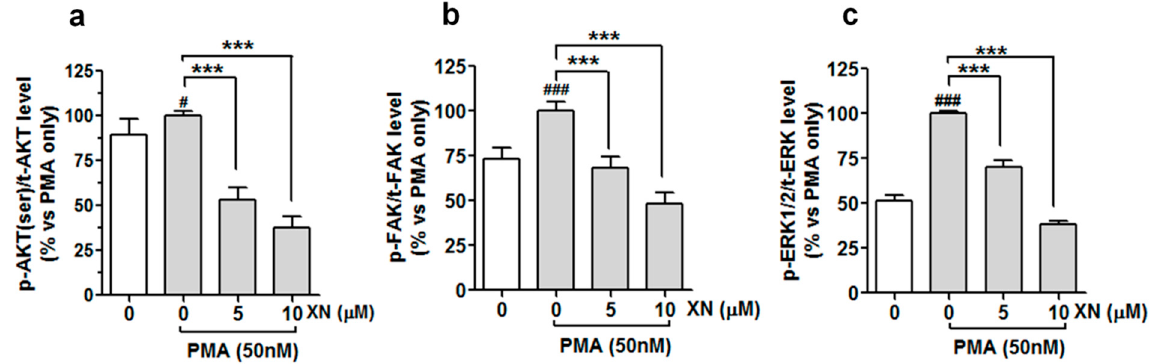
Figure 6. XN interferes with PMA-dependent activation of AKT, FAK, and ERK1/2, kinases in A549 cells. The cells were pre-treated with XN for 4 h and then co-treated with PMA for 24 h; the amounts of phosphorylated ERK1/2, FAK, and AKT were determined with the ELISA assay. Quantitative analysis of ( a ) p-AKT/tAKT, ( b ) p-FAK/tFAK, and ( c ) p-ERK/tERK ratio. Data are expressed as means ± SD of three independent experiments. *** p < 0.001 compared to the PMA-only treatment, # p < 0.05 or ### p < 0.001 compared to the non-stimulated cells; one-way ANOVA test.